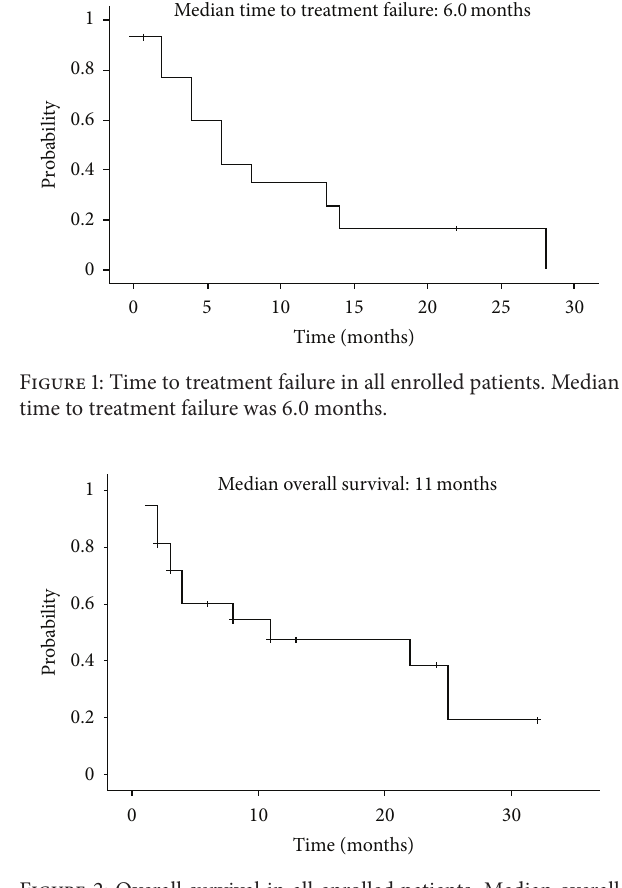
Figure 2: Overall survival in all enrolled patients. Median overall survival time was 11 months.